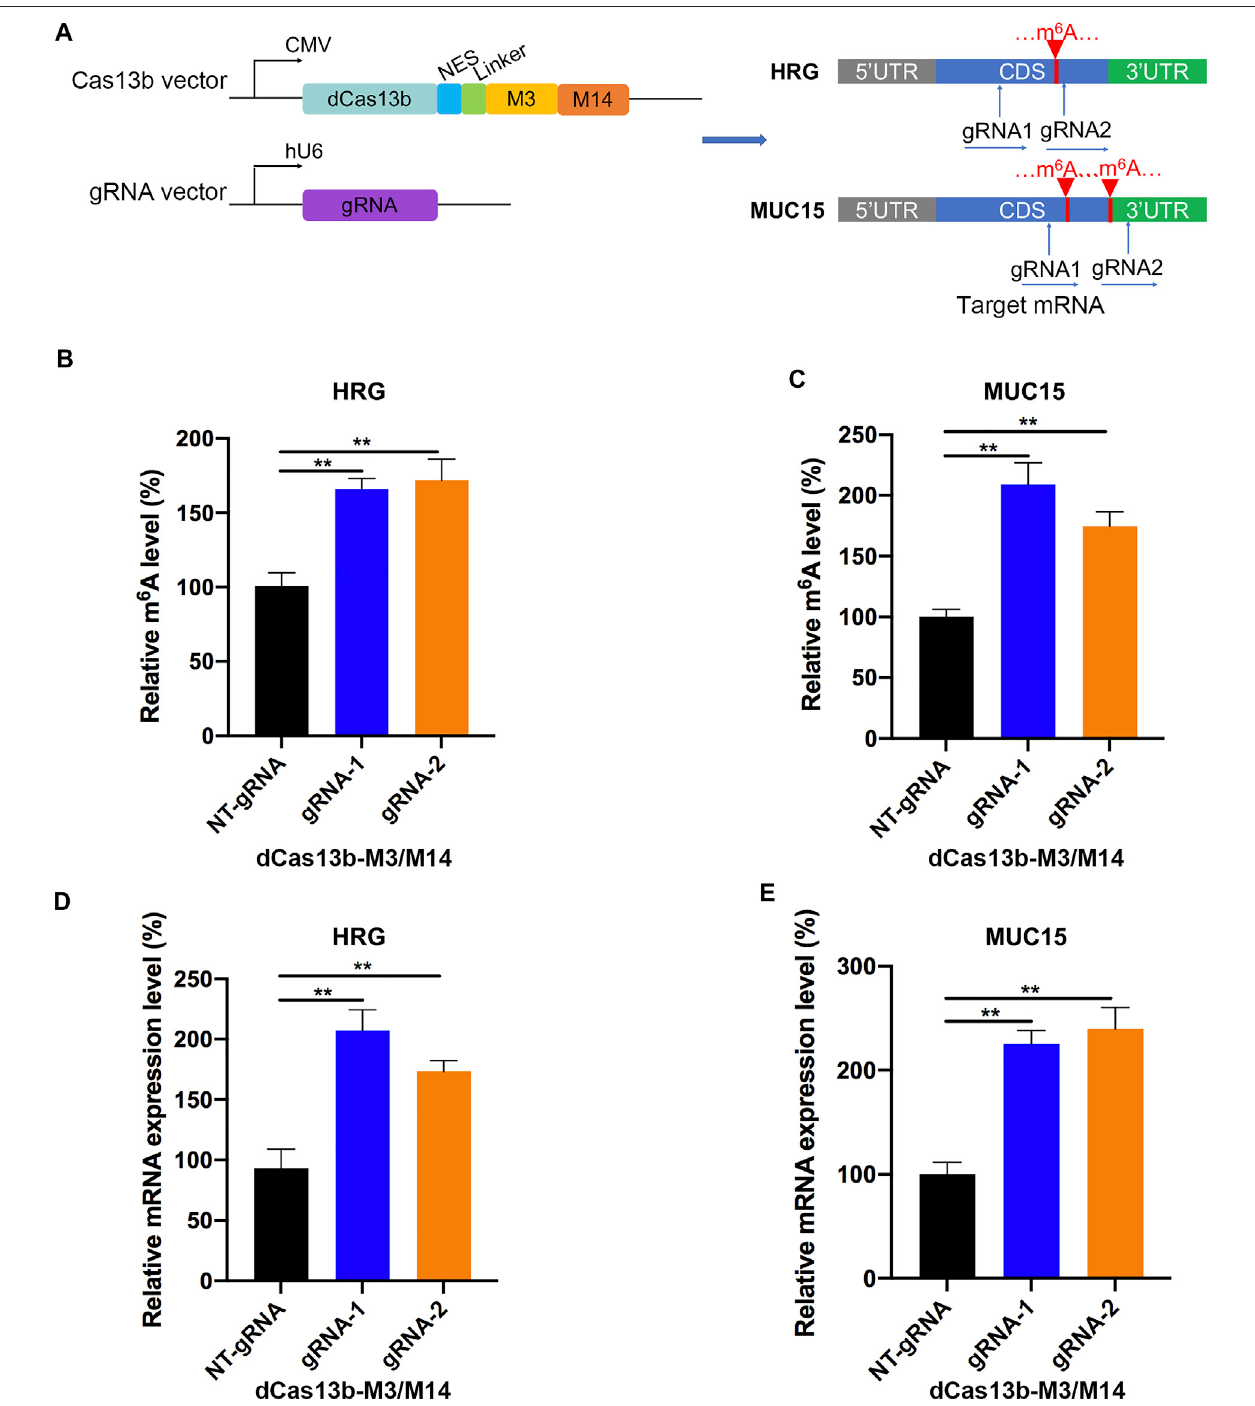
FIGURE 7 | dCas13b-M3M14 induces methylation of m 6 A hypomethylated mRNA in RCC cells. (A) The design of dCas13b-M3M14 fusion protein and sgRNAs targeted with MUC15 and HRG mRNA m 6 A sites. (B,C) The m 6 A level of MUC15 (B) and HRG (C) mRNA in RCC cell line 786-O after transfection with dCas13b- ALKBH5 and gRNAs. (D,E) The mRNA levels of MUC15 (D) and HRG (E) in 786-O cell after transfection with dCas13b-ALKBH5 and gRNAs. ** p < 0.01.